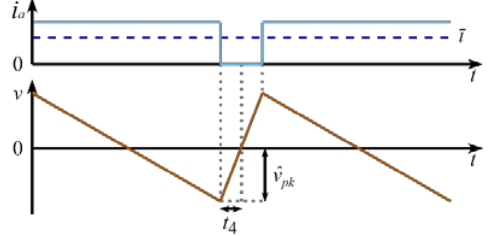
Figure 11. Input current and voltage ripple in one switching period in case of a single-phase unbalanced load (only phase a ).